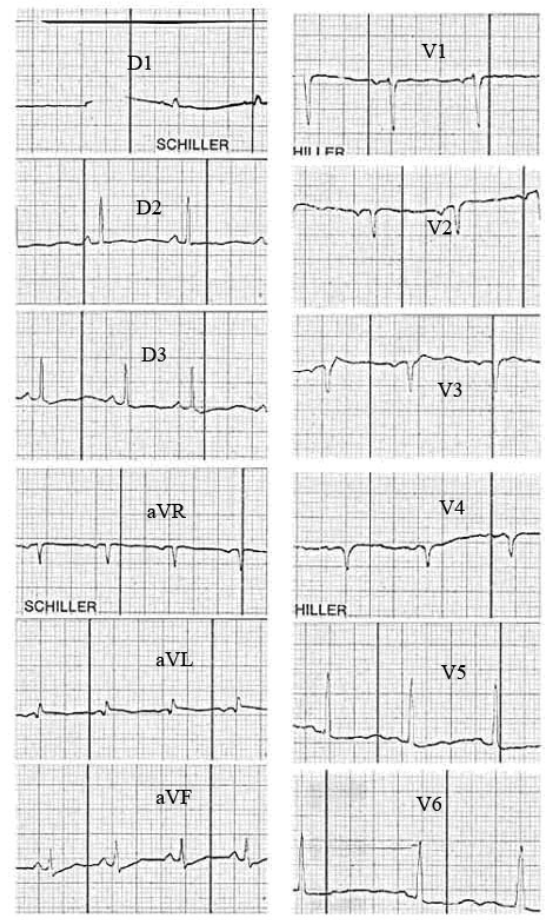
FIGURE 3. Pathological Q waves in leads D1 and aVL. QS configuration in leads V2-V4 and diffuse, flattened T waves in all